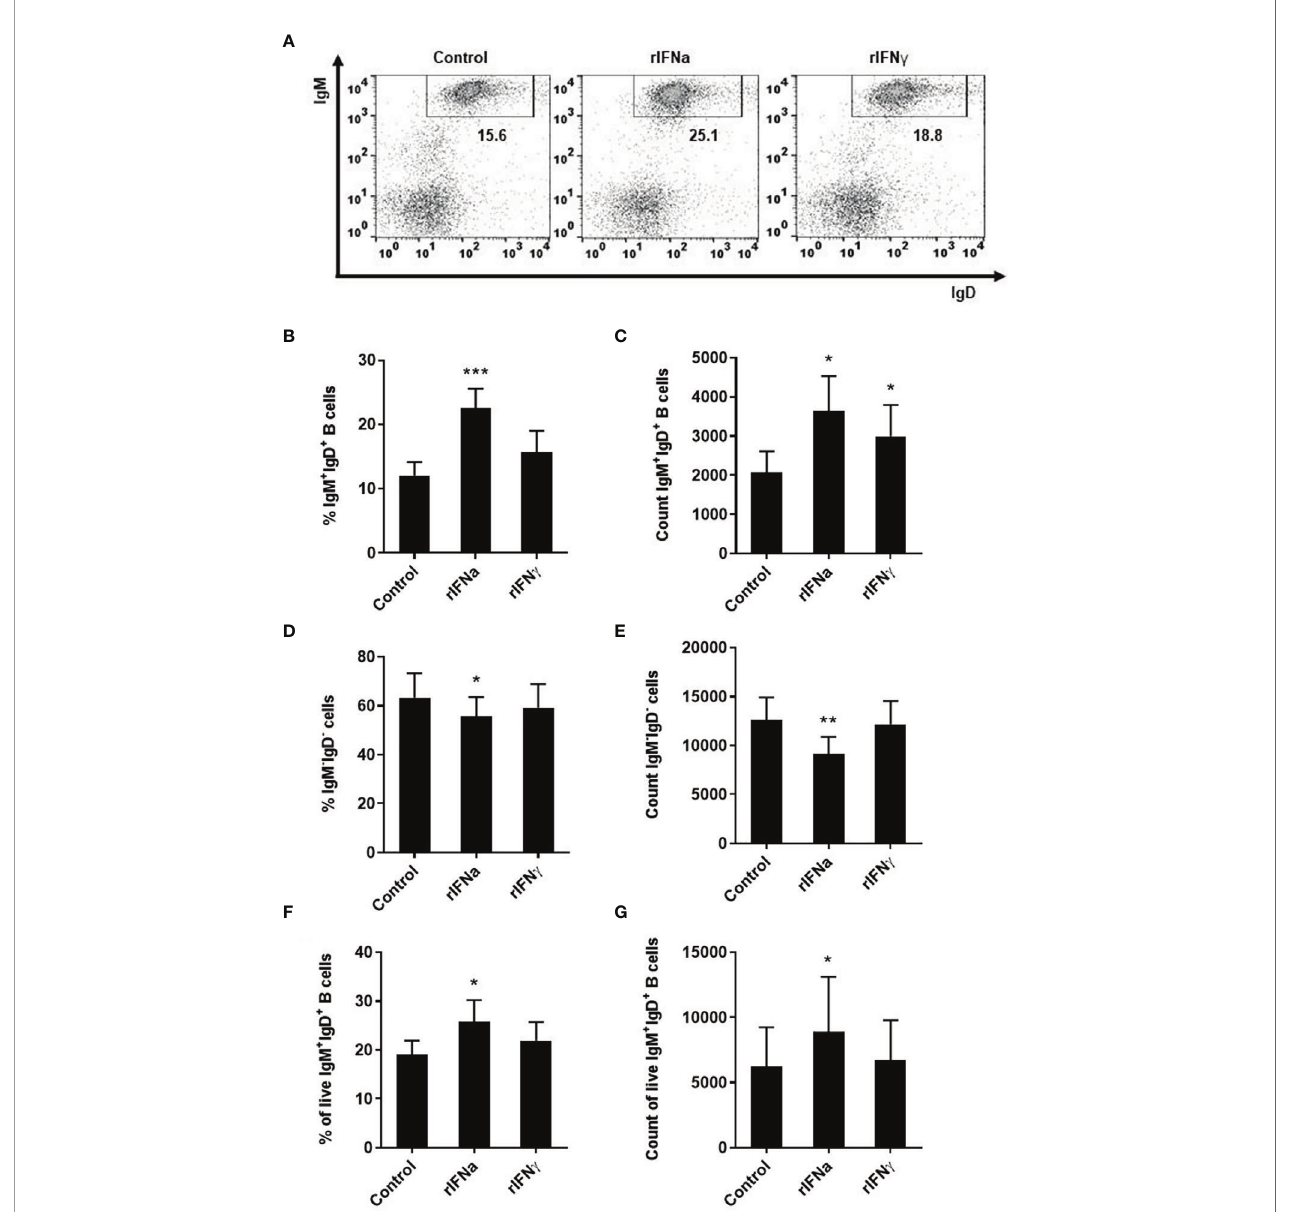
FIGURE 1 | Survival of blood IgM+IgD+ B cells in response to type I and type II IFNs. PBLs were stimulated with 50 ng/ml rIFNa, 20 ng/ml rIFNg or media alone (control) and cultured at 20°C for 72 h. Leukocytes were then labeled with speci fi c monoclonal antibodies against trout IgM and IgD and analyzed by fl ow cytometry. Cells were gated on the basis of their FSC and SSC and percentages of IgM+IgD+ cells determined on singlet and live (DAPI negative) cells. Representative dot plots from one individual fi sh are shown (A) along with mean percentages and total number of cells detected for IgM+IgD+ B cells (B) and IgM − IgD − cells (C) (mean + SEM; n = 9). In an independent experiment, B cells were sorted from blood leukocytes using a biotinyilated Fab fragment of anti-IgM 1.14 and then incubated with the rIFNs as described above. After 72 h, the percentage of live IgM+IgD+ B cells and the total number of live IgM+IgD+ B cells determined by fl ow cytometry as described in the Materials and Methods section (mean + SEM; n = 7) (D) . Asterisks denote signi fi cant differences between samples treated with rIFNs and control samples (*P ≤ 0.05, **P ≤ 0.01, ***P ≤